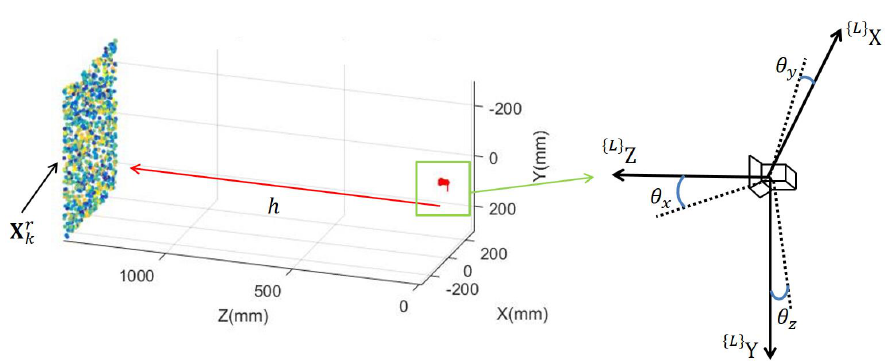
Figure 5. Camera and road surface in the simulation environment. Table 1. Parameters for simulated road surface and simulated